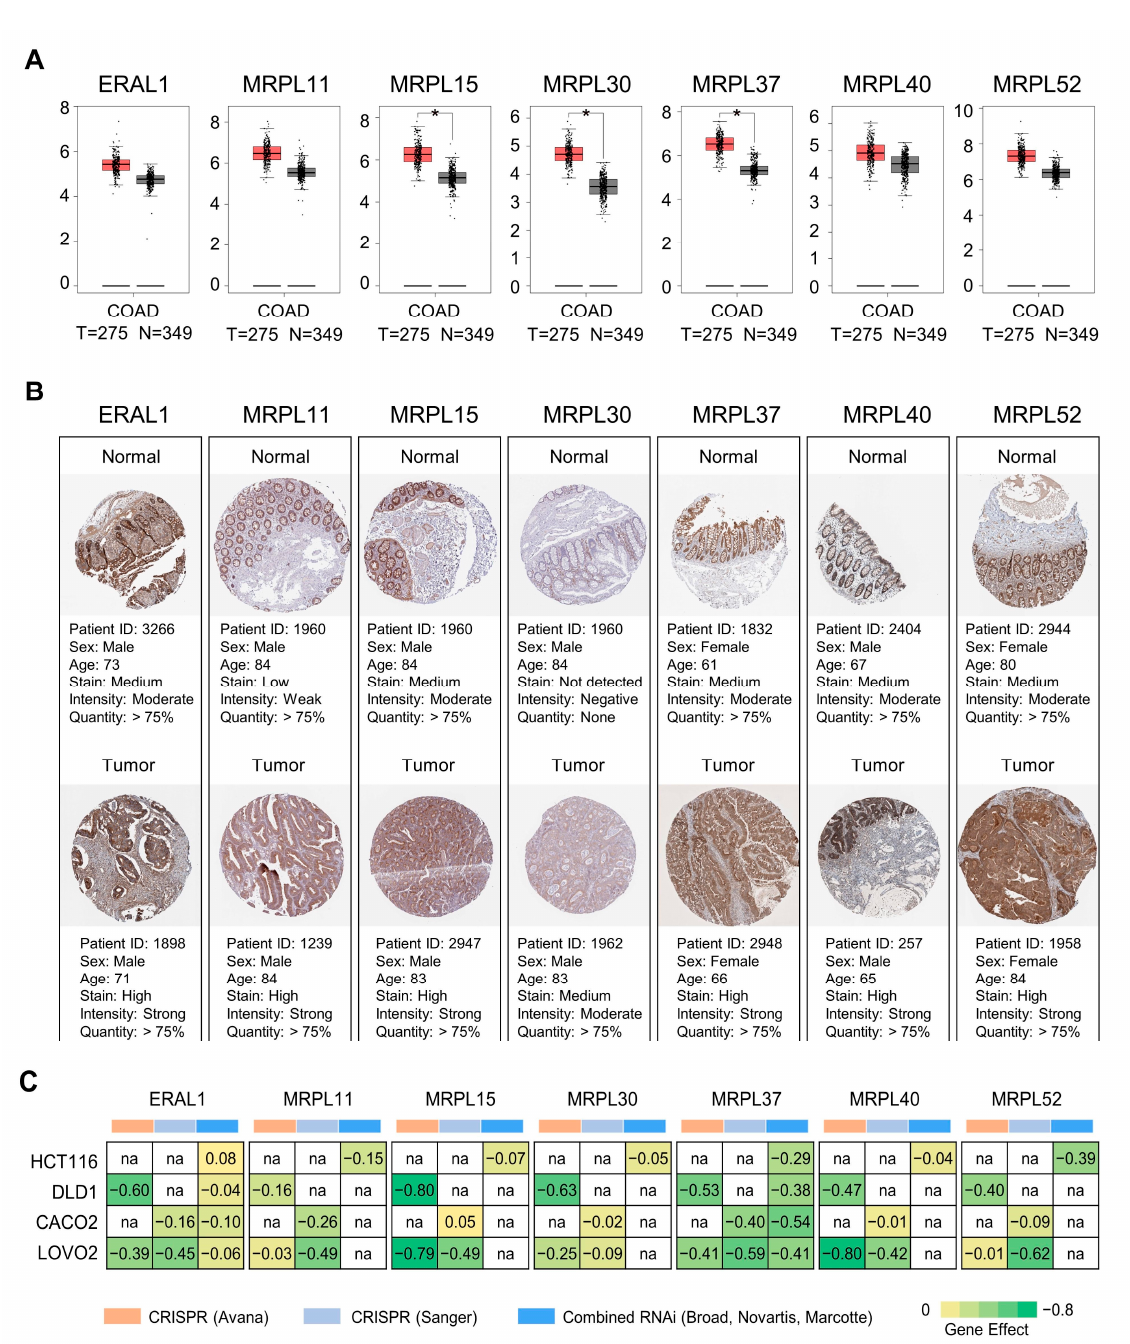
likely to be a potential target. For gene effect, a more negative number denotes a greater dependency in a given cell line, and minimum value in four colon cancer cell lines was selected as dependency score. The dependency scores of ERAL1, MRPL11, MRPL15, MRPL30, MRPL37, MRPL40, and MRPL52 for the four cell lines ranged from − 0.8 to − 0.49. These values indicated that silencing the genes expression of seven hub proteins by CRISPR-Cas9 or RNAi can significantly inhibit the proliferation of four colon cancer cells.